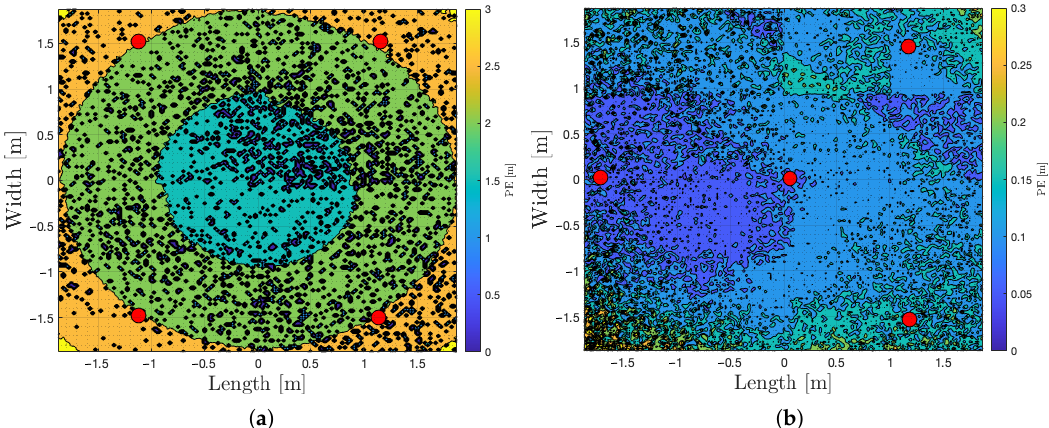
Figure 7. Spatial distribution of the PE for a square and star-shaped LED configuration (red circles denote Tx locations). Based on the work in [218].